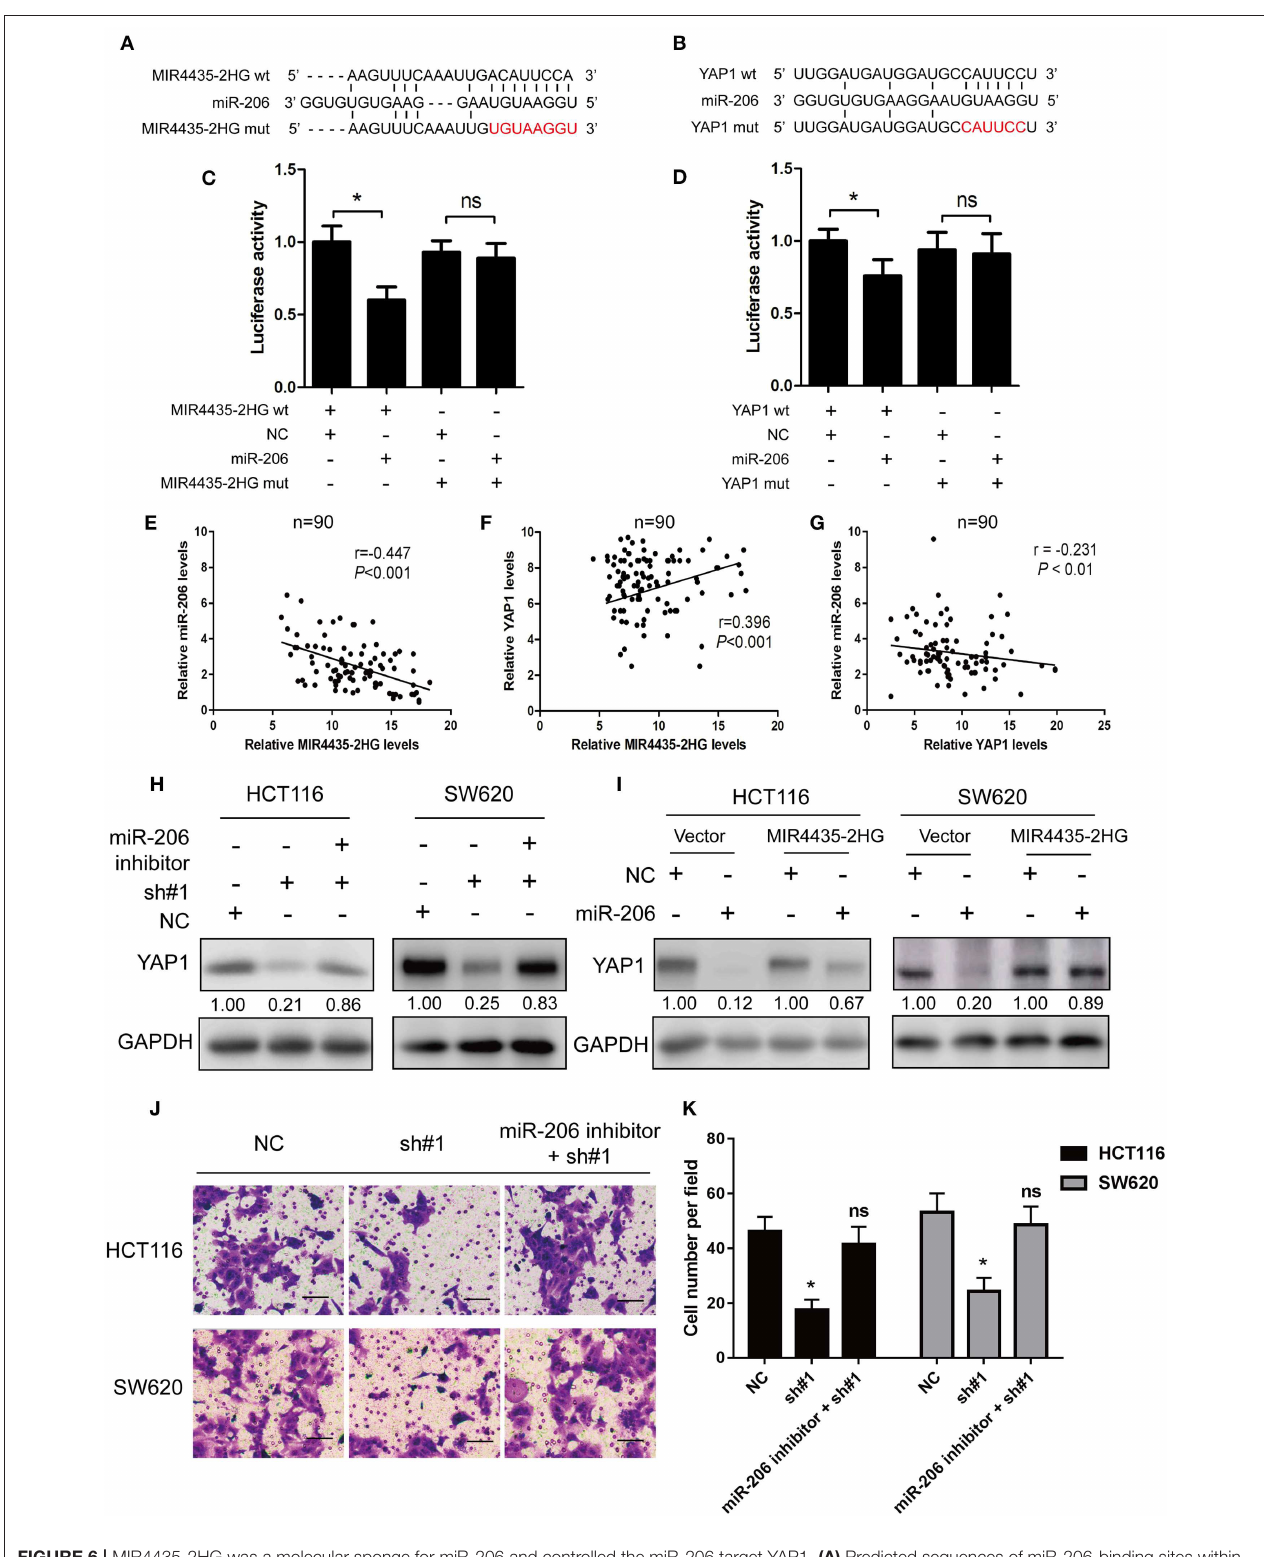
FIGURE 6 | MIR4435-2HG was a molecular sponge for miR-206 and controlled the miR-206 target YAP1. (A) Predicted sequences of miR-206-binding sites within MIR4435-2HG. MIR4435-2HG wt, miR-206, and MIR4435-2HG mutants (mut) sequences were used in Luciferase reporter gene assays. (B) Estimated sequences of miR-206-binding sites within the 3 ′ -UTRs of YAP1 and sequences of YAP1 and YAP1 3 ′ -UTR mutants (mut) were adopted here. (C) Luciferase reporter gene assays